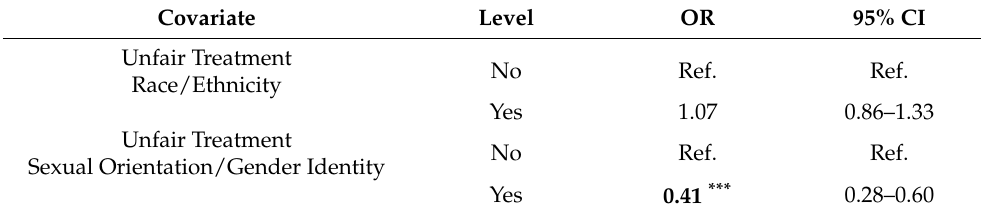
Table 3. Unadjusted odds ratios from weighted simple logistic